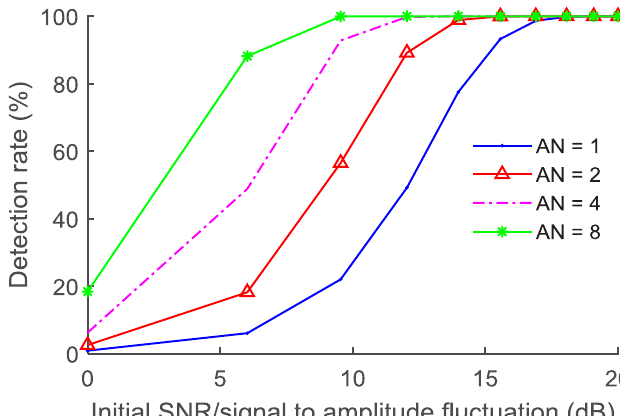
Figure 6. Performance of the BDD method under the different SNR of the processed